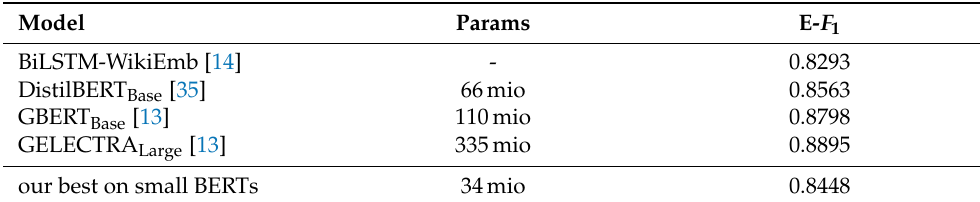
Table 11. Comparison of our best results on the GermEval-task with other state of the art models, where E- F 1 is the entity-wise F 1 score. Our shown result is again the average of 3 fine-tuning runs. The score of DistilBERT was taken from https://huggingface.co/dbmdz/flair-distilbert-ner-